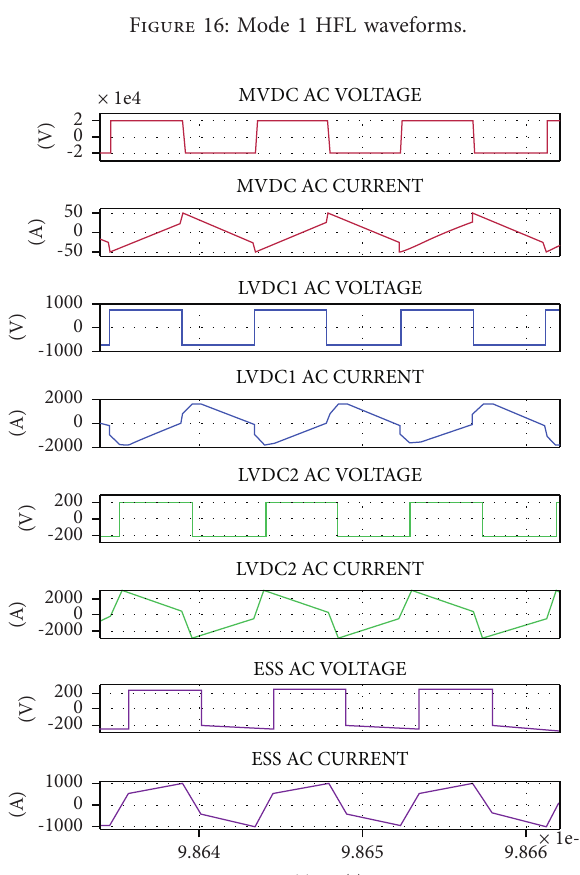
Figure 17: Mode 2 HFL